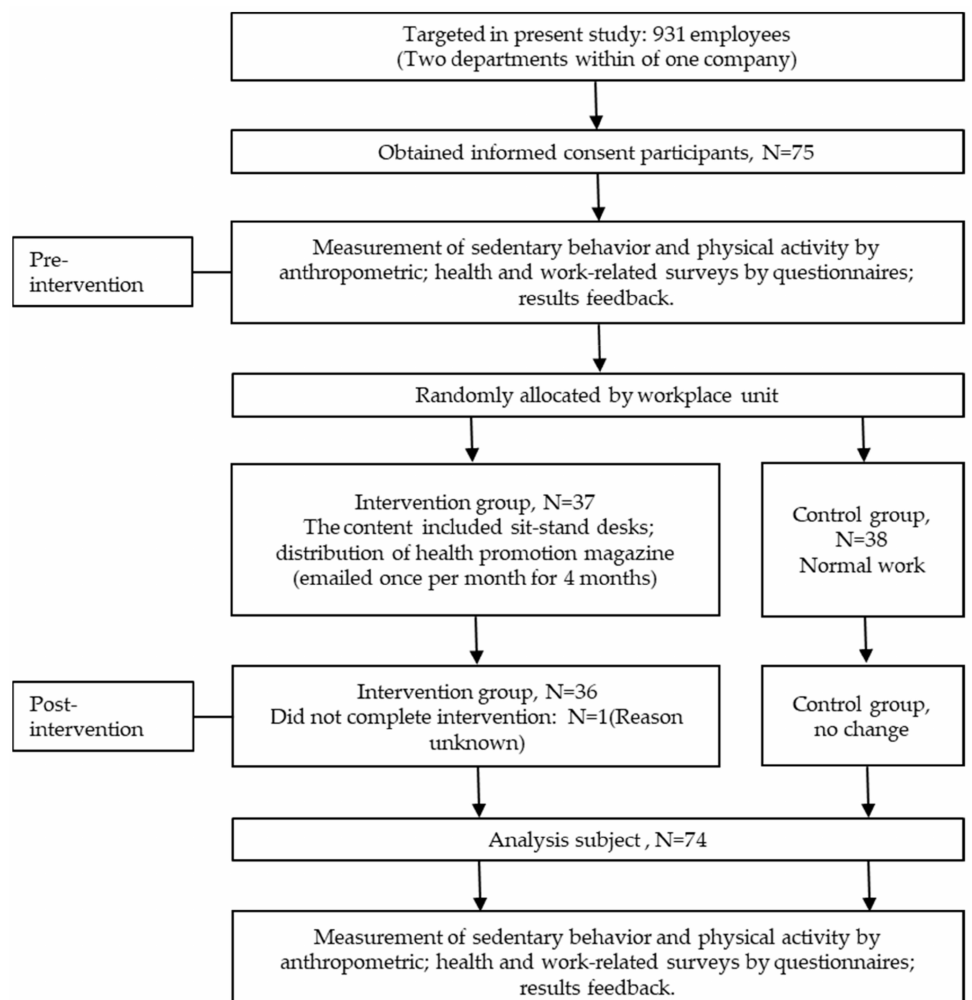
Figure 1. Flow chart of participants and protocol of intervention.